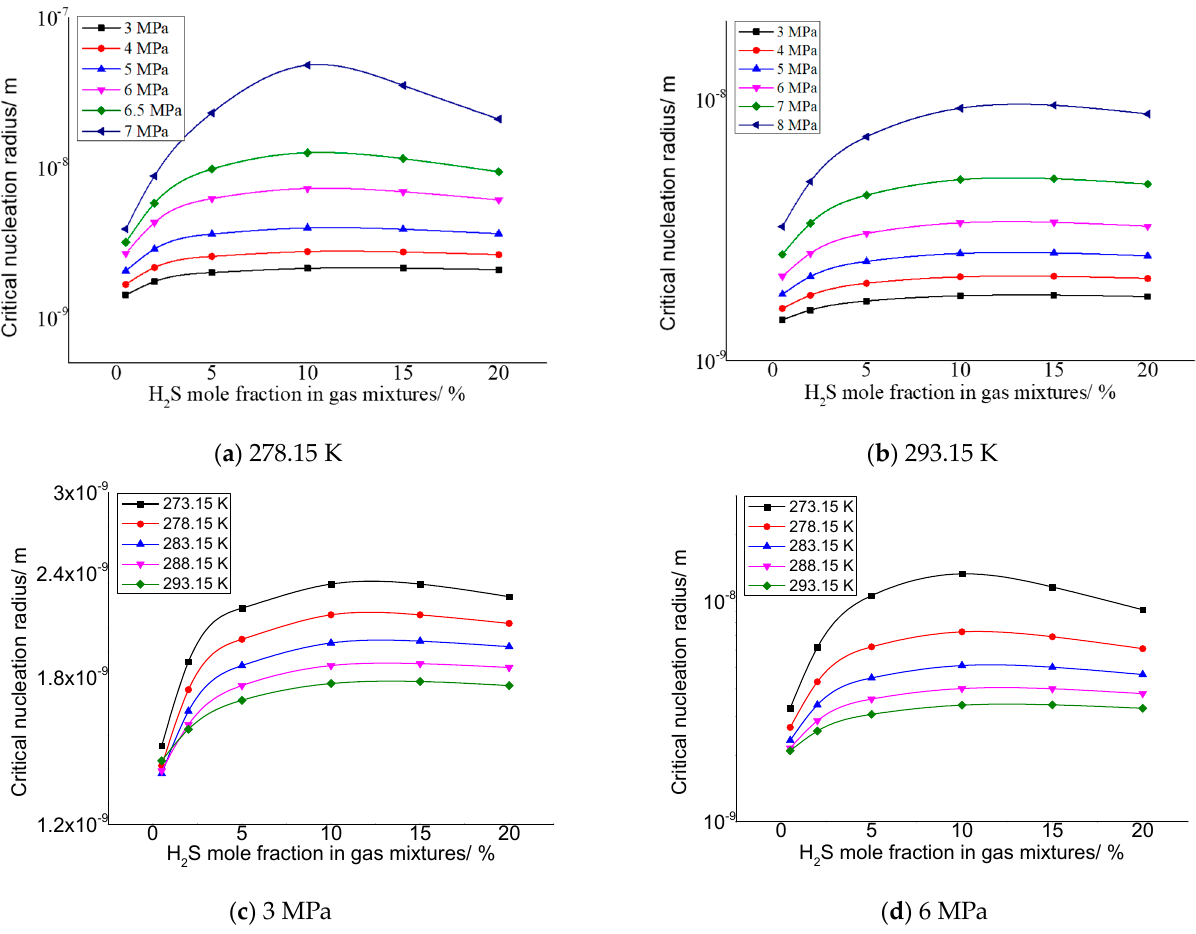
Figure 3. The variation curve of critical nucleation radius with H 2 S concentration.